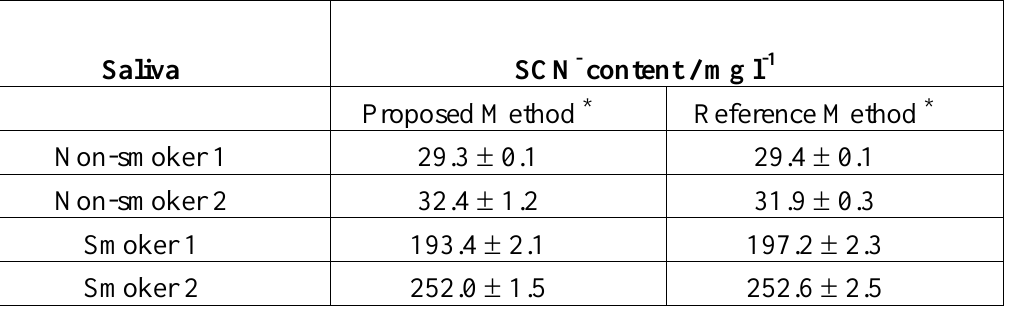
Table 3 Determination of anion thiocyanate in human saliva.